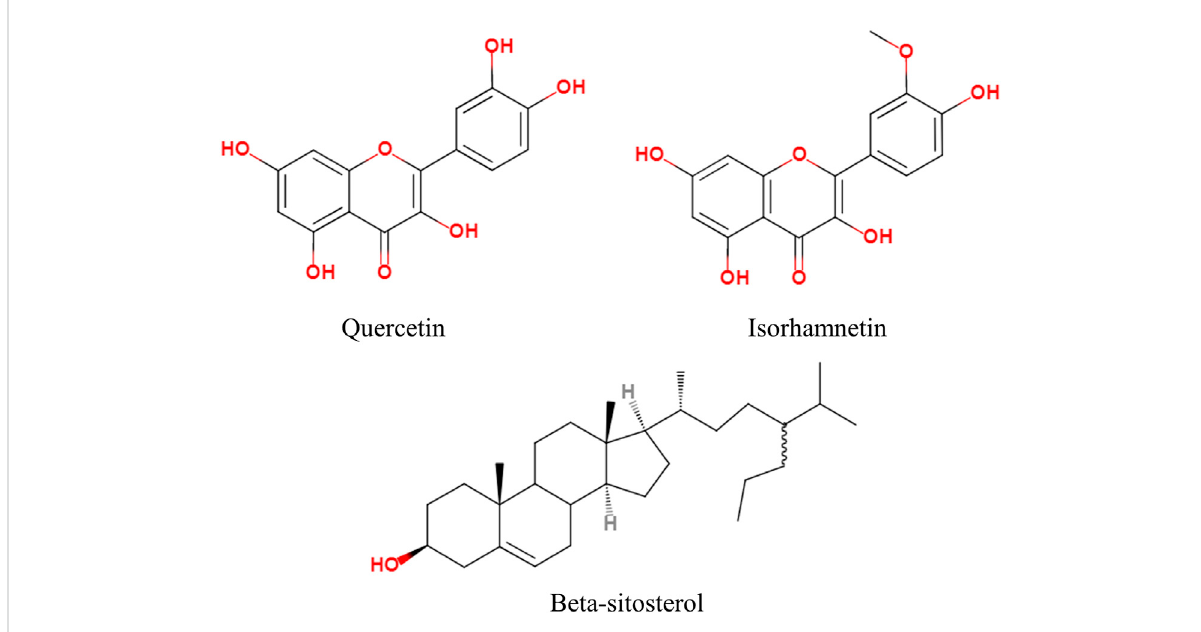
FIGURE 4 Chemical structure formulas of the top three active components of PD.